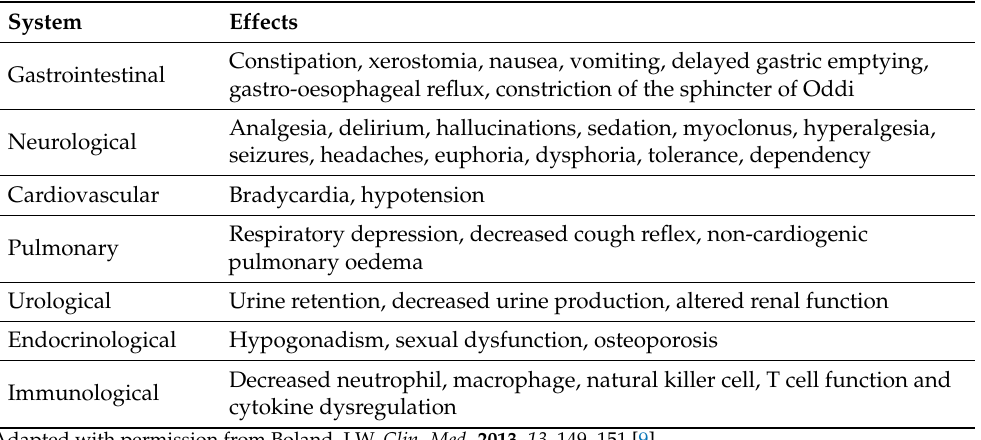
Table 1. Effects of opioids on different organ